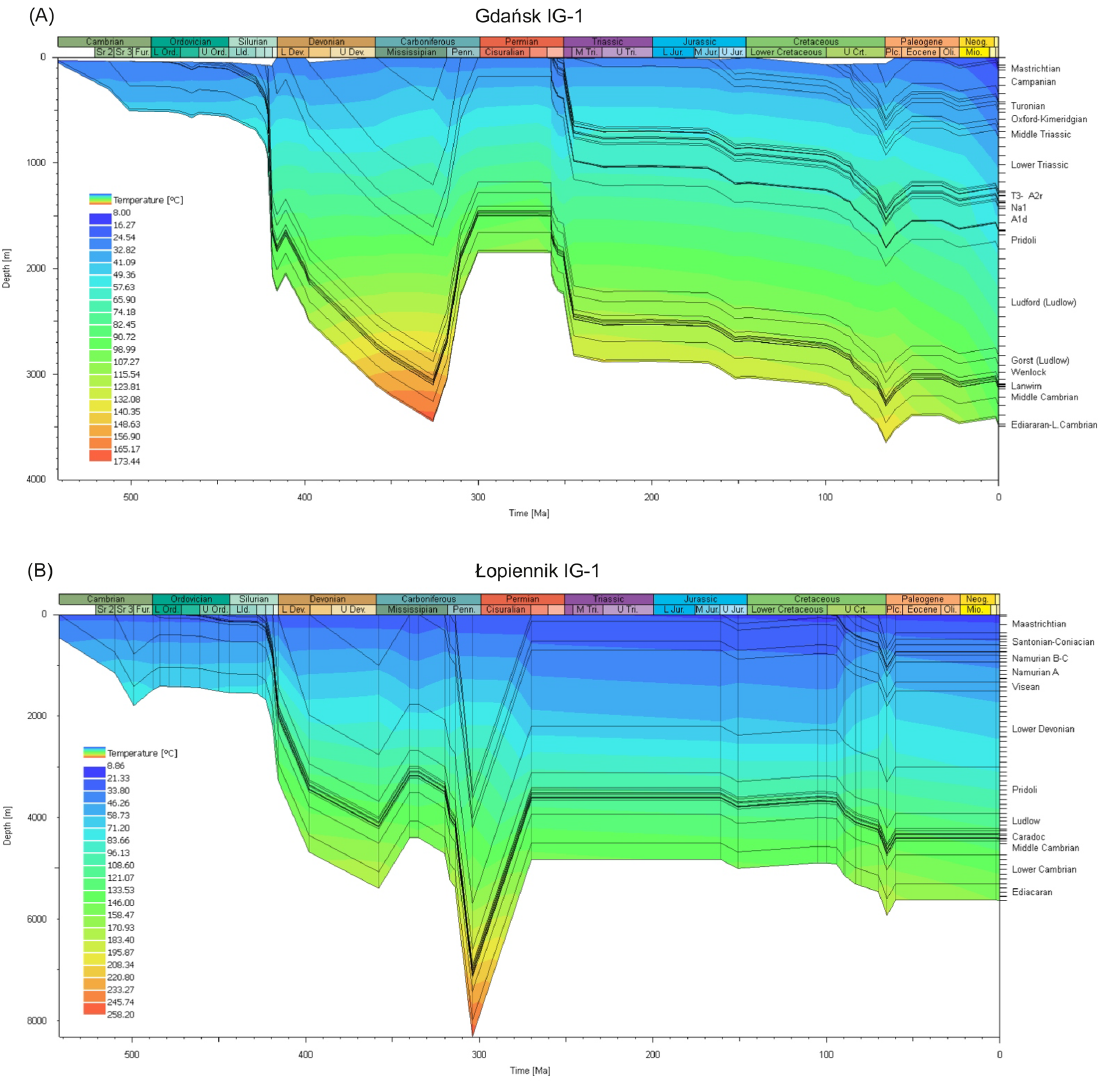
Figure 5. Representative burial history plots for the (a) Baltic Basin and (b) Lublin Basin after Botor et al. (2019a). In the Baltic and Lublin basins, a maximum temperature in the lower part of the Ediacaran–Paleozoic sedimentary succession was reached in the early and latest Carboniferous,